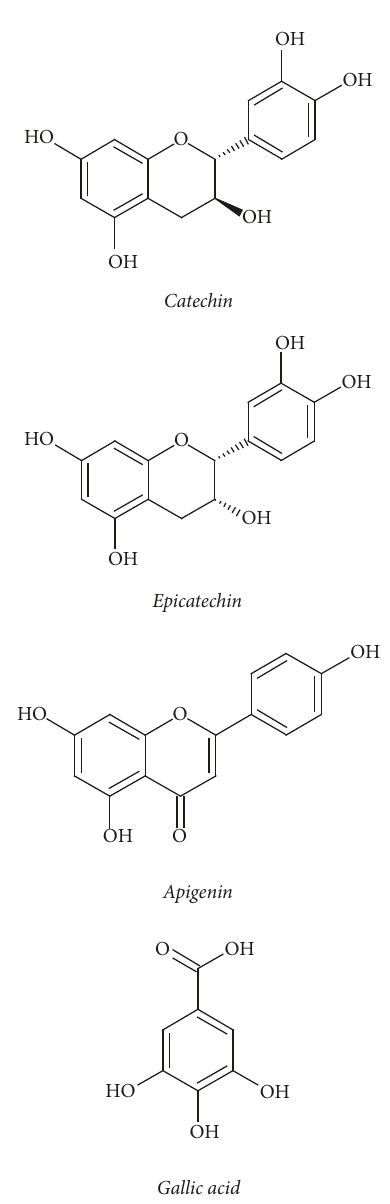
Figure 4: Structures of the substances detected in